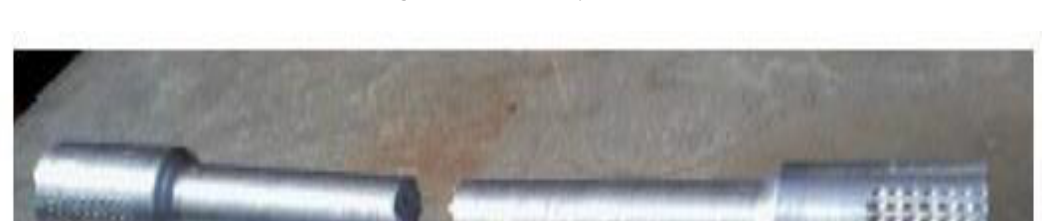
Fig. 9. Tensile test specimen